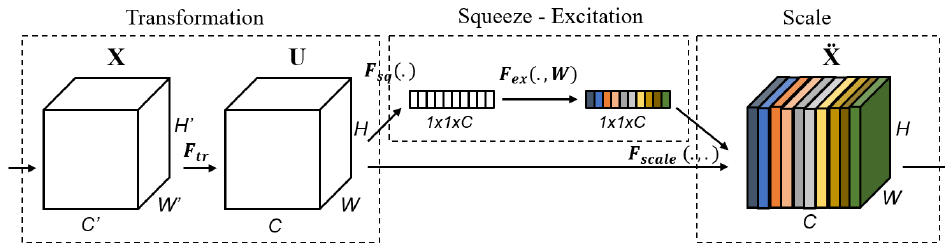
Figure 2. The Squeeze-and-Excitation (SE) Block.